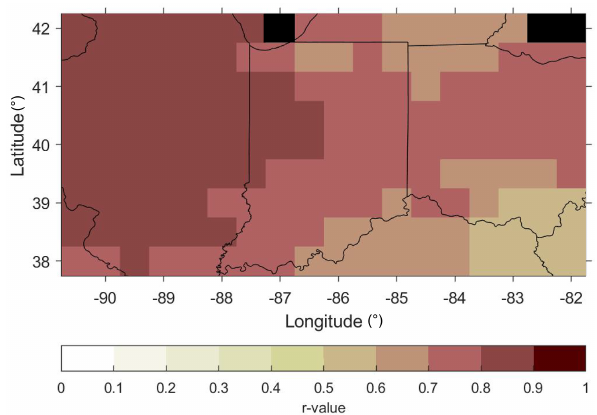
Figure 2. Map of correlation values between the LBDA and ORV reconstruction during the period of 1830–2005CE. The correlations of each grid shown in the map are all significant at the 0.05 level. The black cells represent locations over the Great Lakes, and there- fore no data are available for correlation analysis.